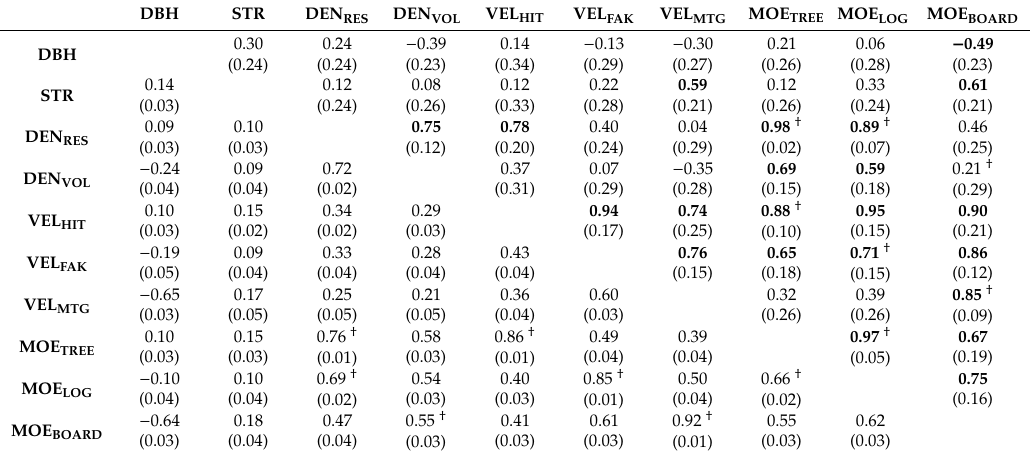
Table 5. Additive genetic ( r A , above diagonal) and phenotypic ( r P , below diagonal) correlations among growth and wood quality traits (standard errors in